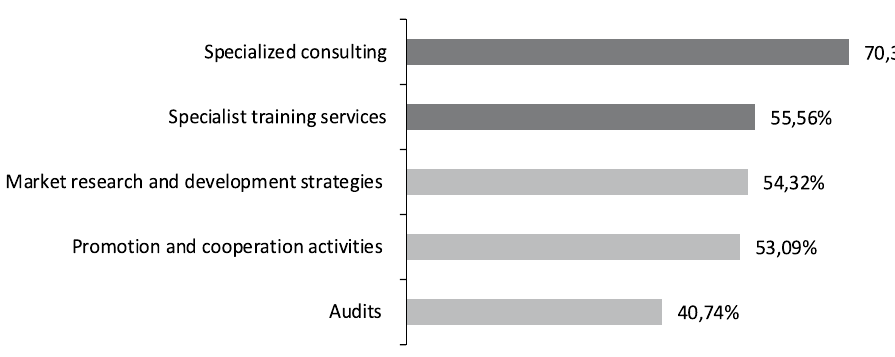
Figure 4. Expectations of the surveyed companies regarding the type of services offered by the Regional Centre for Future Industrial Competence. CAWI surveys